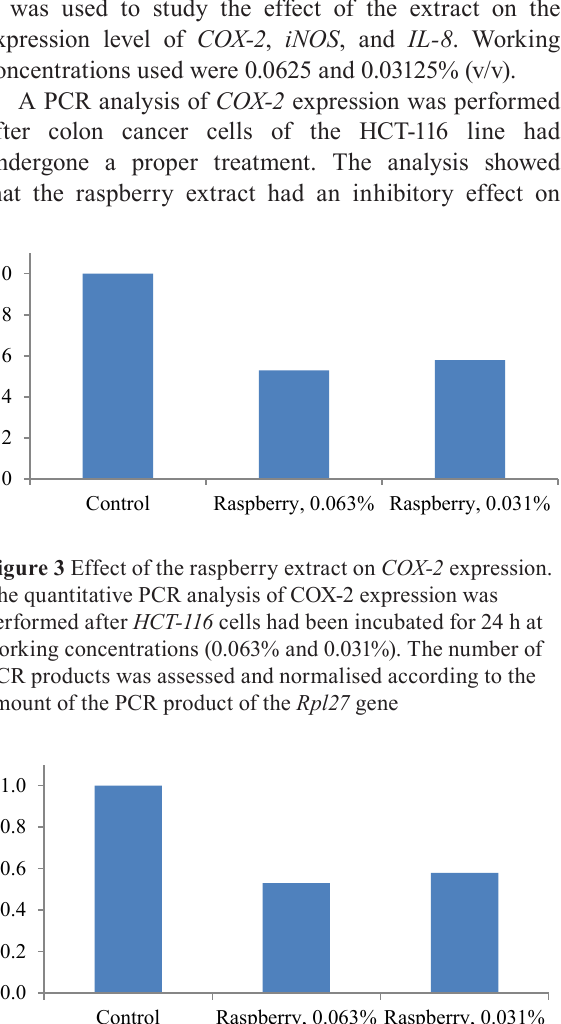
Figure 5 Effect of the raspberry extract on IL-8 expression. The quantitative PCR analysis of IL-8 expression was performed after HCT-116 cells had been incubated for 24 hours at working concentrations (0.063% and 0.031%). The number of PCR products was assessed and normalized according to the amount of the PCR product of the Rpl27